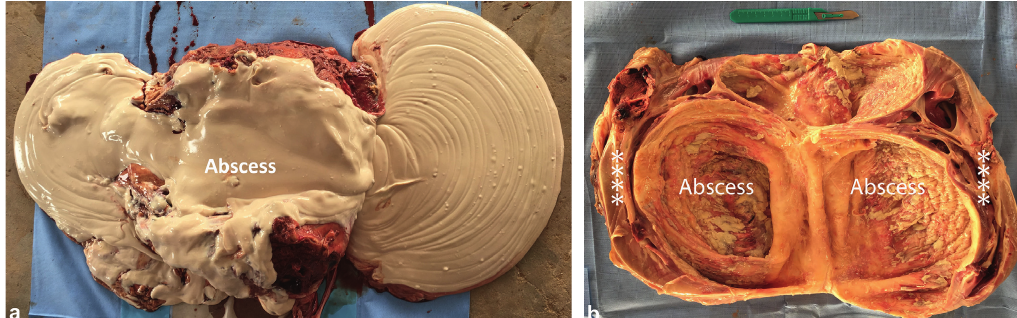
Figure 14: Gross pathological findings in a male camel with bilateral renal abscessation and chronic active pyelonephritis caused by Escherichia coli . Image (a) shows gross appearance of the left kidney and thick creamy pus evacuated from the kidney, weighting about 18kg. Image (b) shows a longitudinal section through the affected kidney after complete evacuation of the large abscess revealed thickening and dilatation of the renal pelvis in relation to the renal abscess [30]. Stars point to the renal tissue.